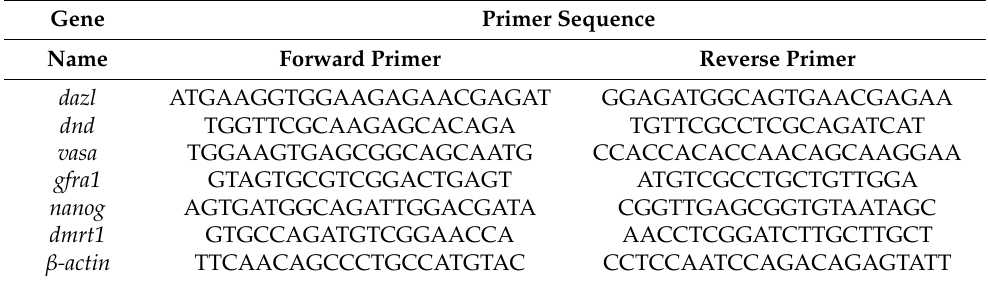
Table 1. Primers used for reverse transcription polymerase chain reactions